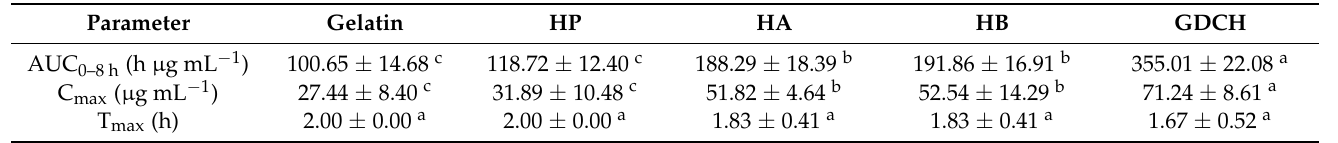
Table 1. Pharmacokinetic parameters of the total Hyp in rat plasma after ingestion of gelatin and hydrolysates (HA, HB, HP, and GDCH).